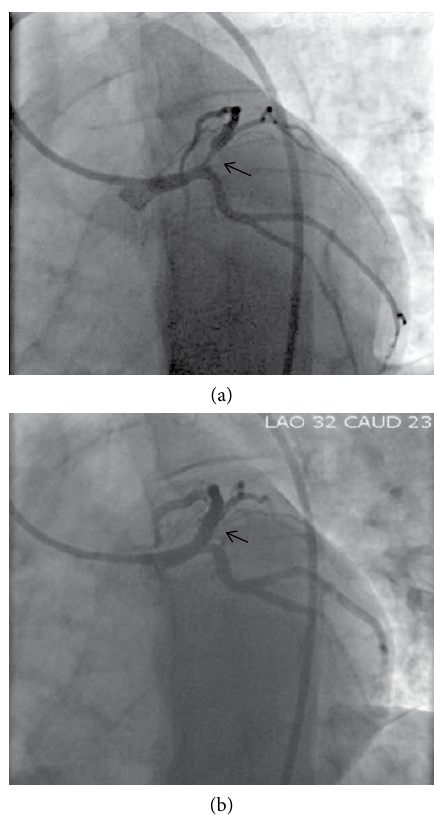
Figure 2: Coronary angiography. Image A shows critical ostial LAD stenosis. Image B shows patent ostial LAD after successful deployment of drug-eluting